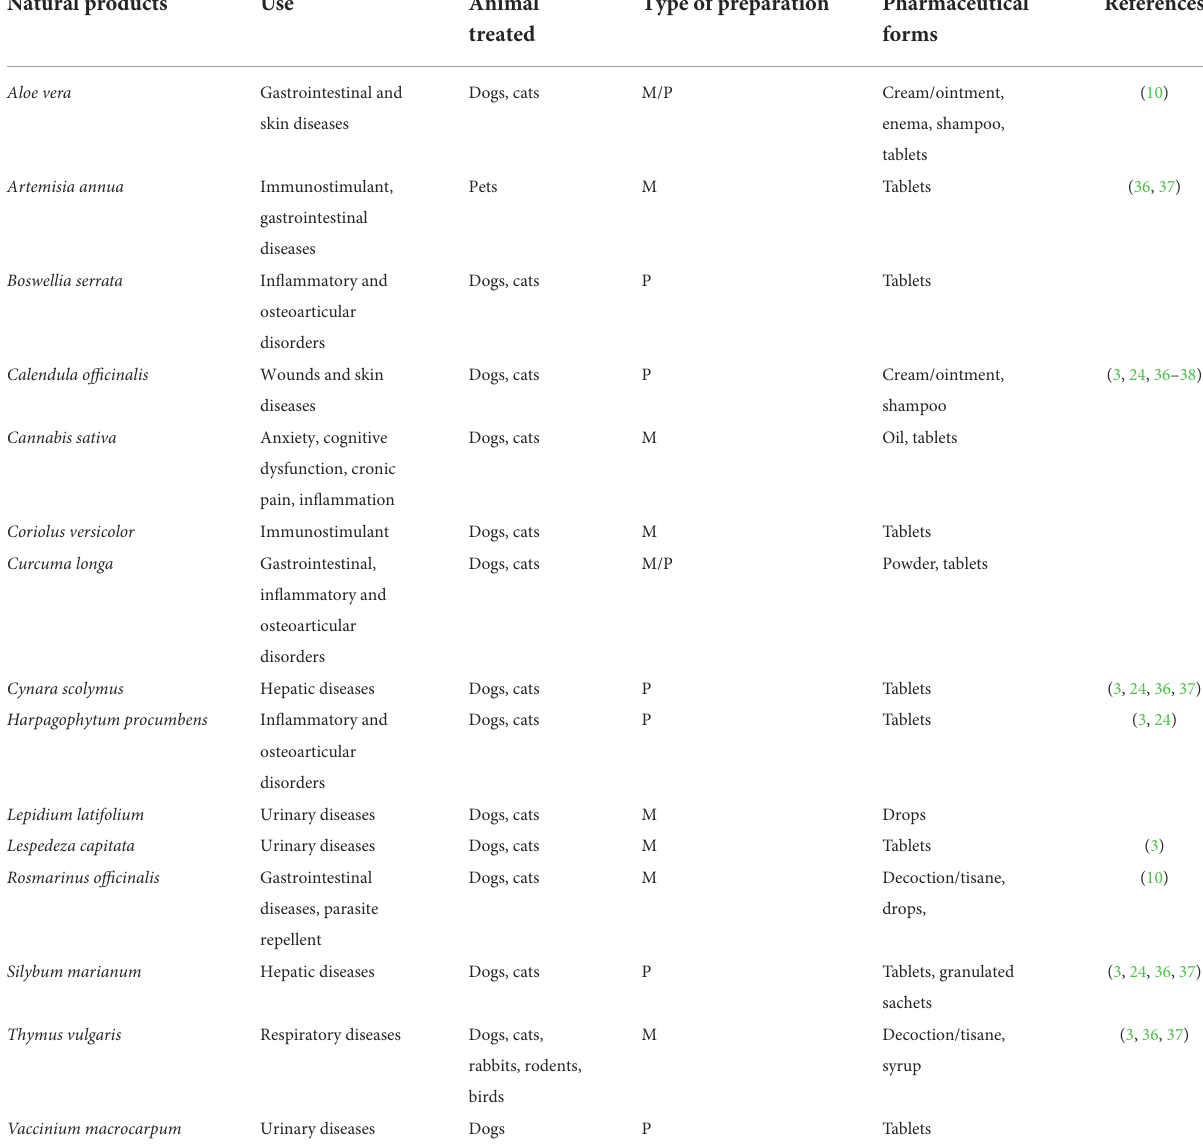
TABLE 5 List of the top 15 natural products commonly employed by Spanish small animal veterinarians, along with their use, animal treated, type of preparation, pharmaceutical form and references of previous studies describing its use. Natural